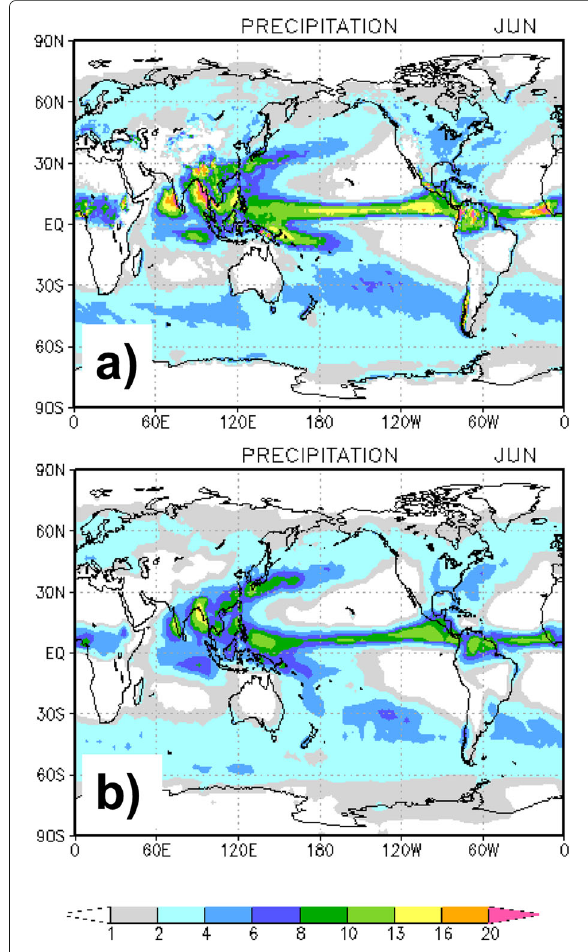
Fig. 5 a Precipitation climatology (mm/day) for June in the past climate simulations of d4PDF-G and b corresponding observations (GPCP; Adler et al.